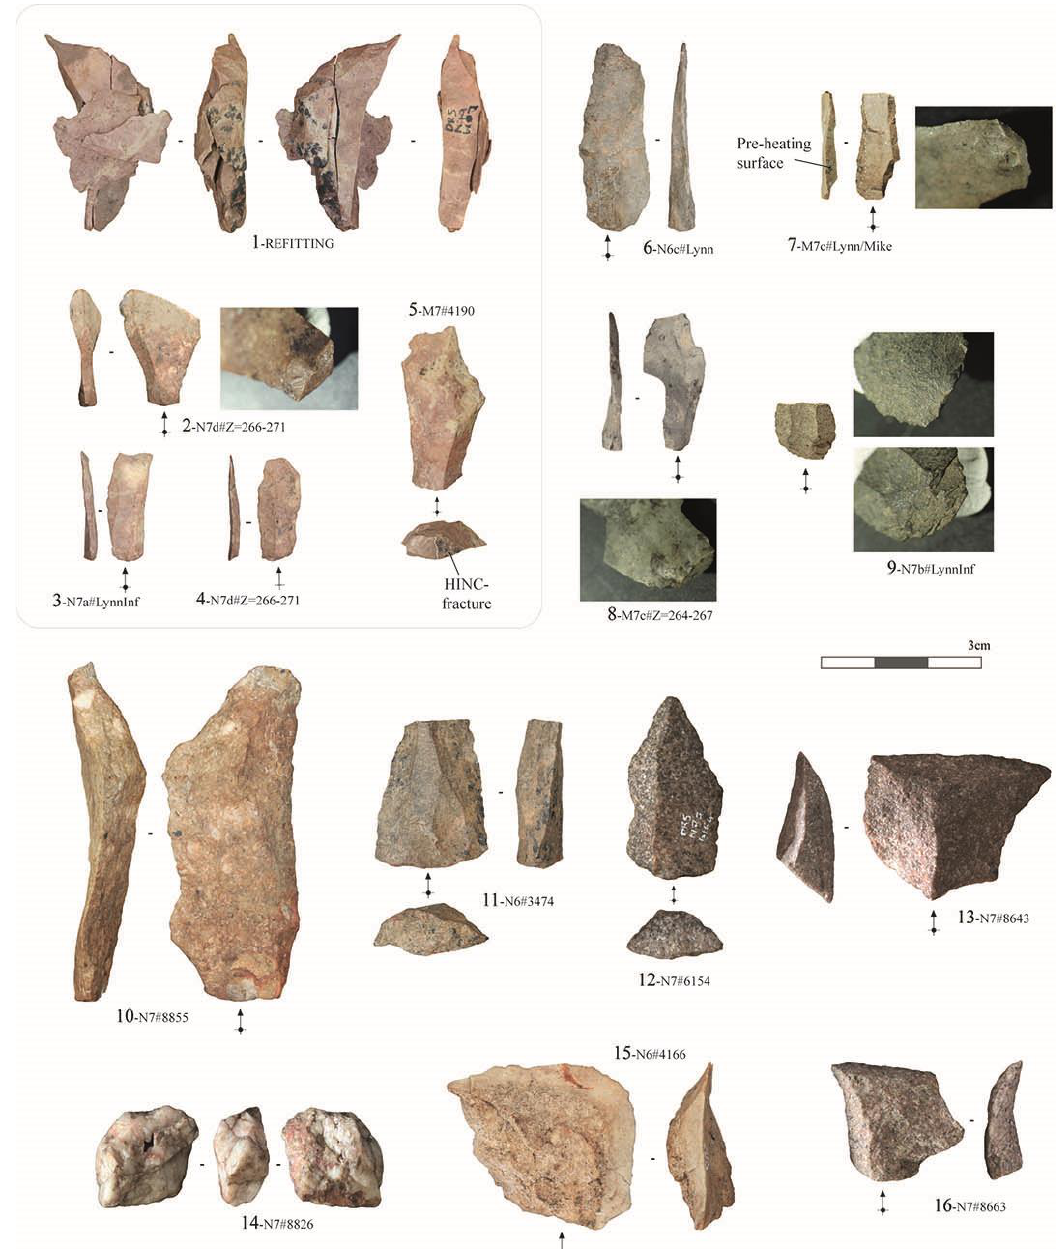
Figure 7 . Blanks from the stratigraphic unit Lynn at Diepkloof Rock Shelter. N°1: refitting showing the preparation and the extraction of a crested bladelet (see also: Fig. 3, n°1) and the under-crested bladelet. N°2-9: bladelets. N°10: blades. N°11, 12: triangular flakes. N°13, 16: quadrangular flakes. N°14: bipolar core. N°15: cortical flakes. Exotic silcrete except n°10 (local silcrete), n°12-13 (quartzite) and n°14 (quartz). Notice that n°1-9 represent a pinkish marbled yellow silcrete as noticed in Figure 3. A high resolution version of this figure is available at